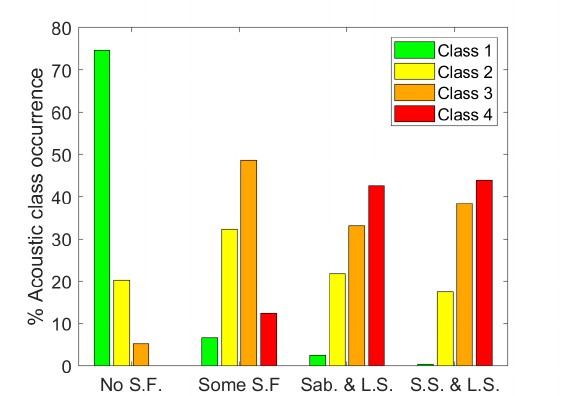
Figure 10. Percentages of occurrence of acoustic classes within one-meter radius of video data points, classified as follows: “Sand with hardly any shell fragments” (No S.F.), “Sand with some shell fragments” (Some S.F.), “Sand with Sabellaria fragments and incidental larger stones” (Sab. & L.S.), or “Sand with small stones and incidental larger stones” (S.S. &